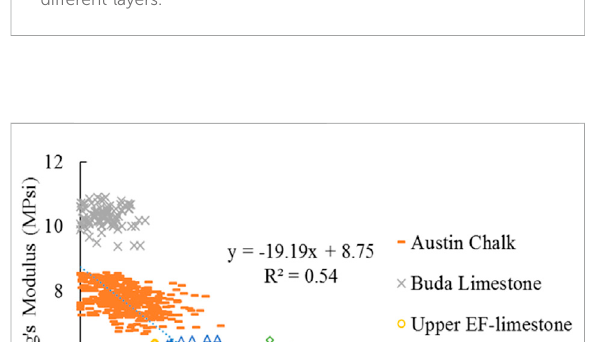
FIGURE 13 Correlations of dynamic Young ’ s Modulus and gamma ray in different layers.